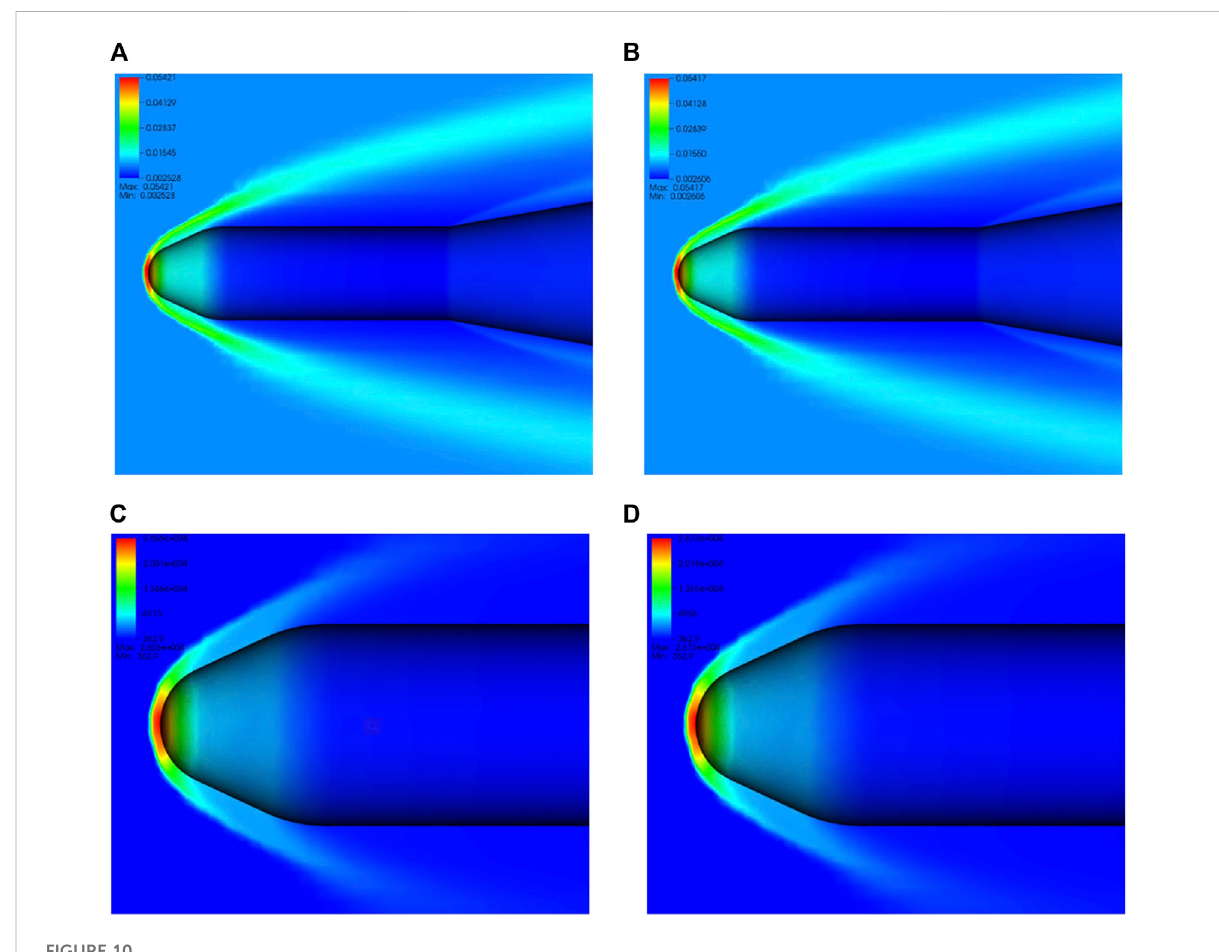
FIGURE 10 Computed fl ow distribution of (A) density with P 1 Q 1 element, (B) density with P 2 Q 2 element, (C) pressure with P 1 Q 1 element and (D) pressure with P 2 Q 2 element for the HB-2 ballistic